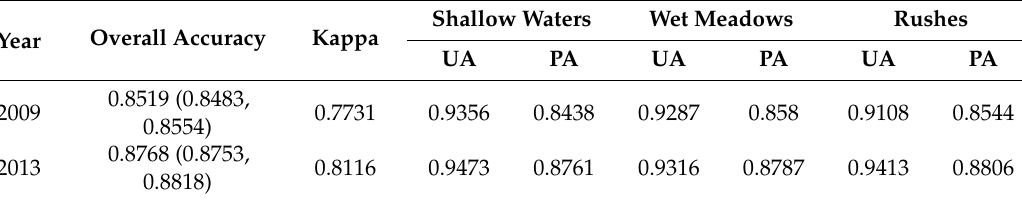
Table 4. Summary of clustering accuracy in comparison with vegetation maps.